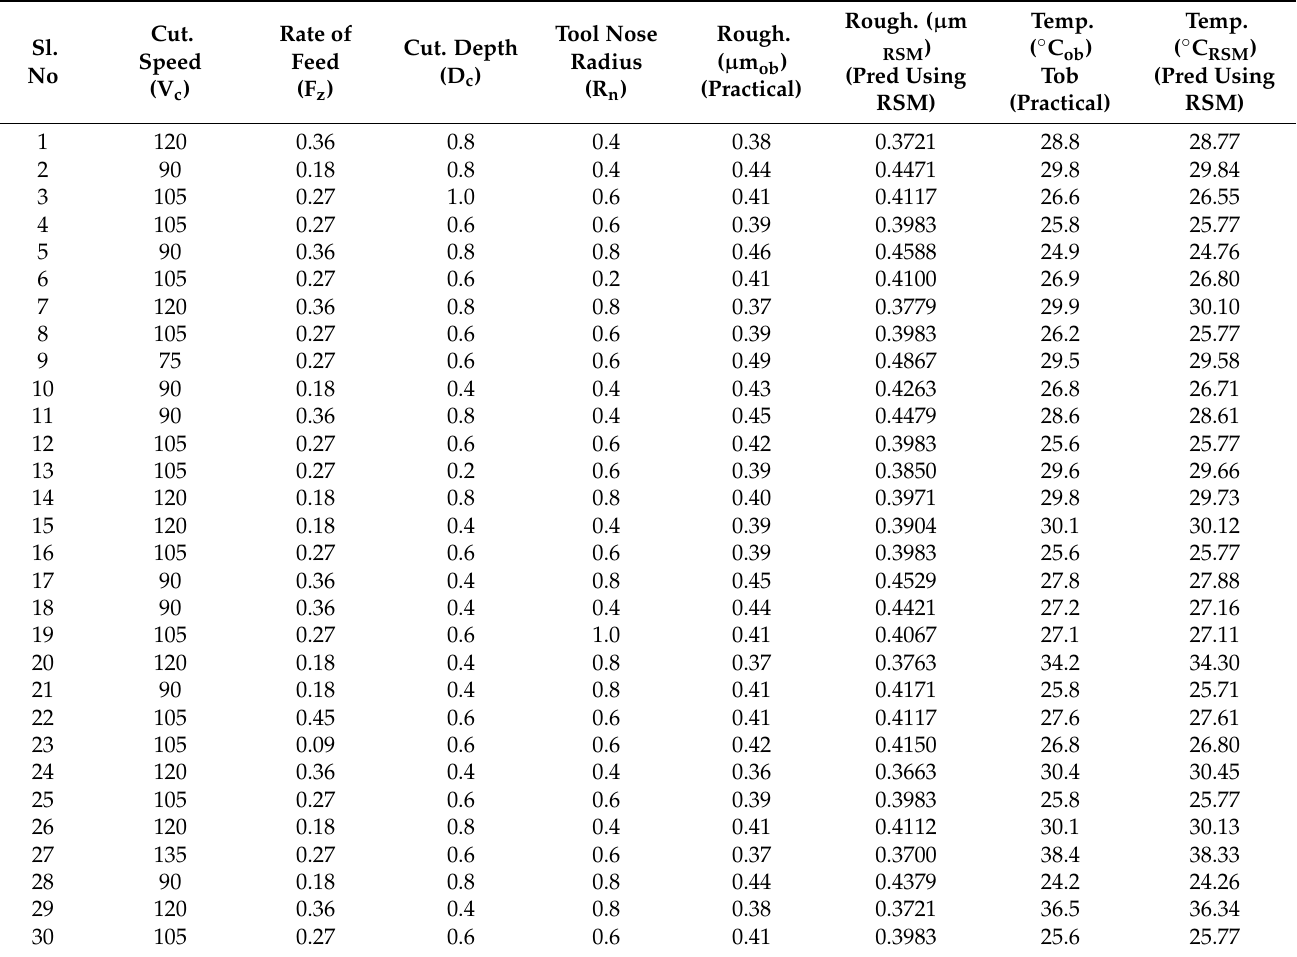
Table 3. Responses to experimental